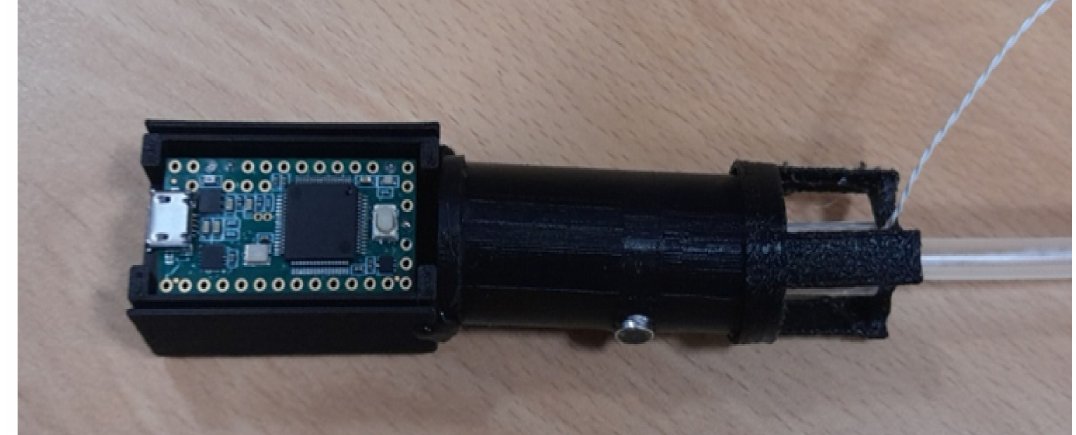
Figure 13. Developed digital esophageal stethoscope system